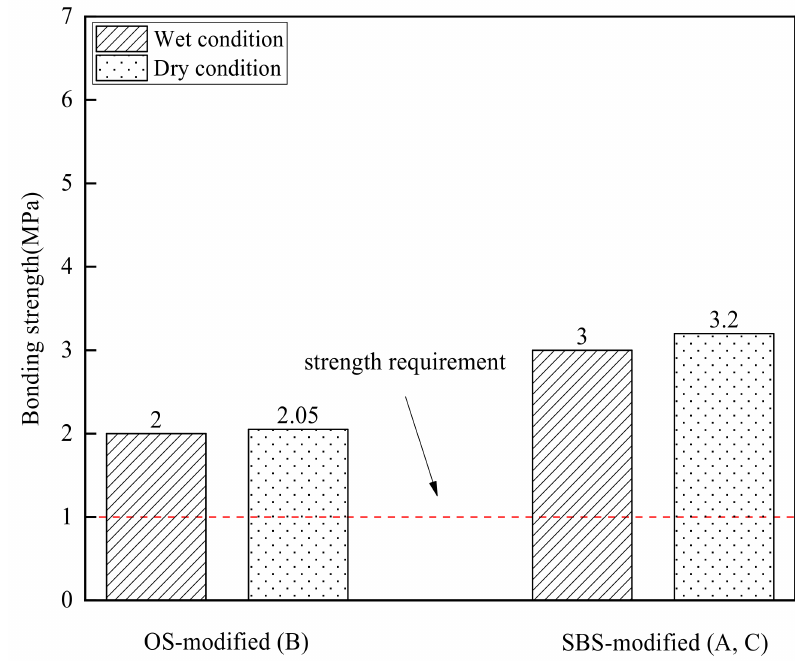
Figure 3. Bonding strengths of the OS-modified and SBS-modified